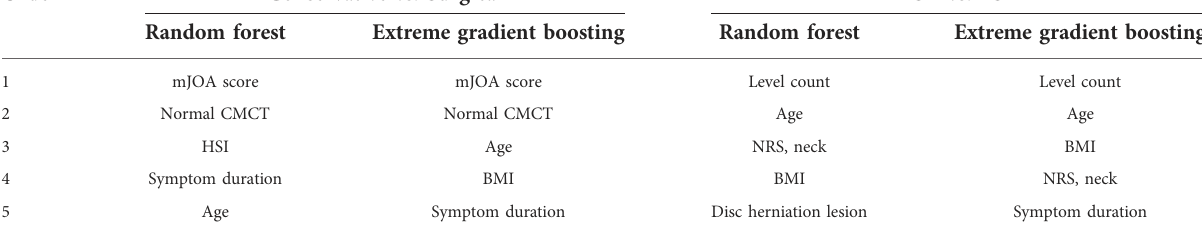
TABLE 5 The top fi ve important variables in each